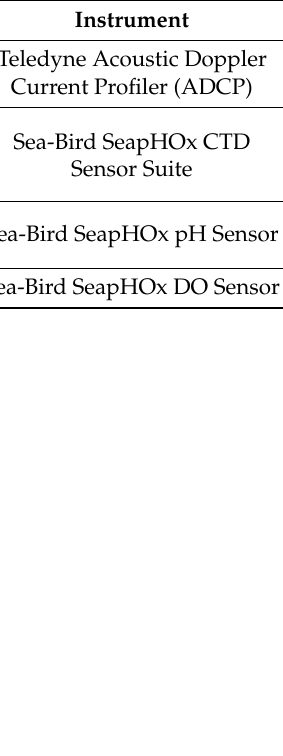
Table 2. Pre- and post-test self-assessment